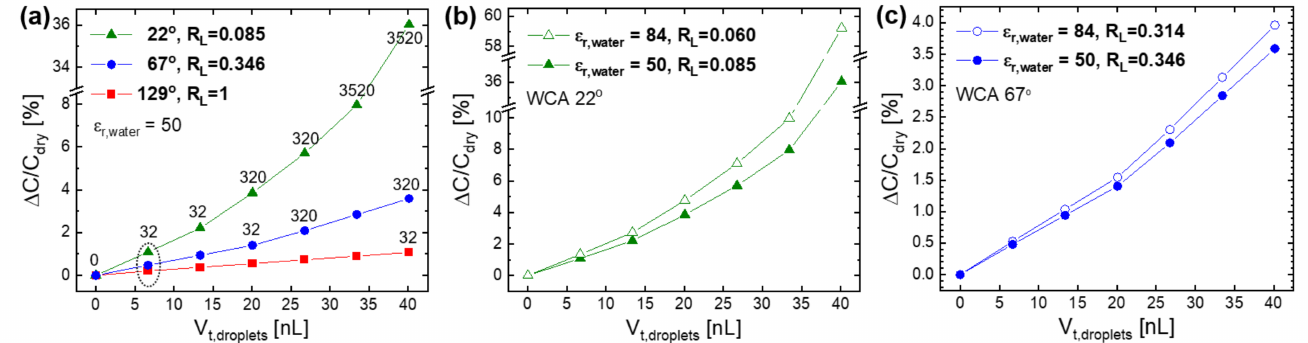
Figure 9. FEM simulation results showing the dependence of the increase in sensor capacitance with the total volume of water droplets and its resulting linearity ratio (R (cid:48) L ) on: ( a ) the WCA of substrate surface (22 ◦ , 67 ◦ , 129 ◦ ) and ( b , c ) the relative permittivity of water (50, 84). It was assumed that the increase in the number of water droplets (32, 288, 3200) when increasing the total volume depended on the WCA of IDE sensor